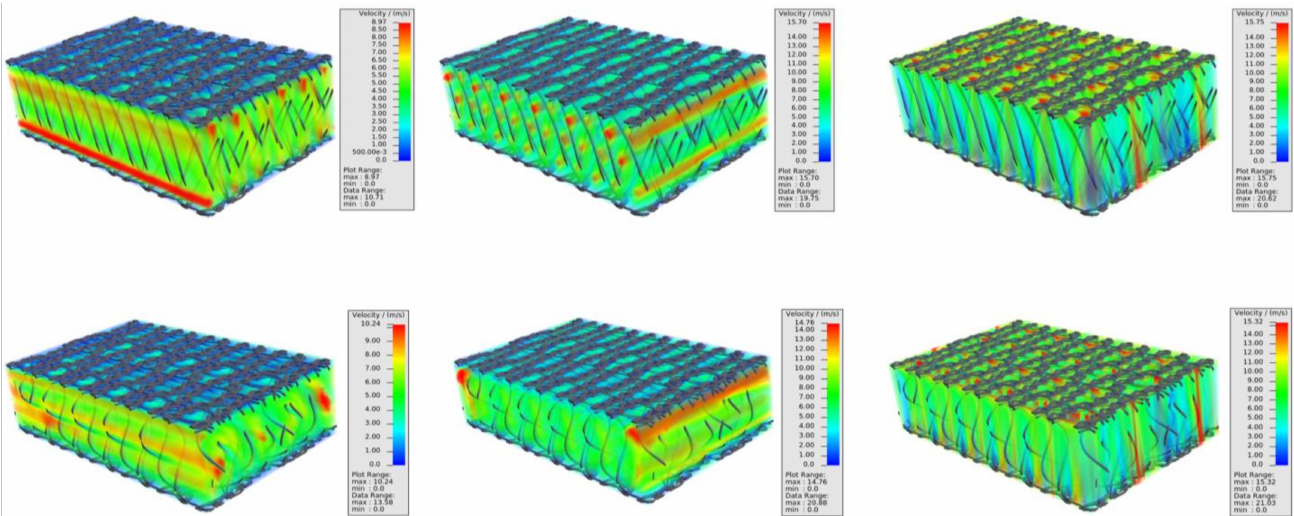
Figure 13. Stationary Stokes flow in a spacer fabric before and after an outer-plane compression, similar to [25]. The flow direction is horizontal in the first two figures and vertical in the third figure in each row, respectively. In Figure 14, the experimental validation from [25] is